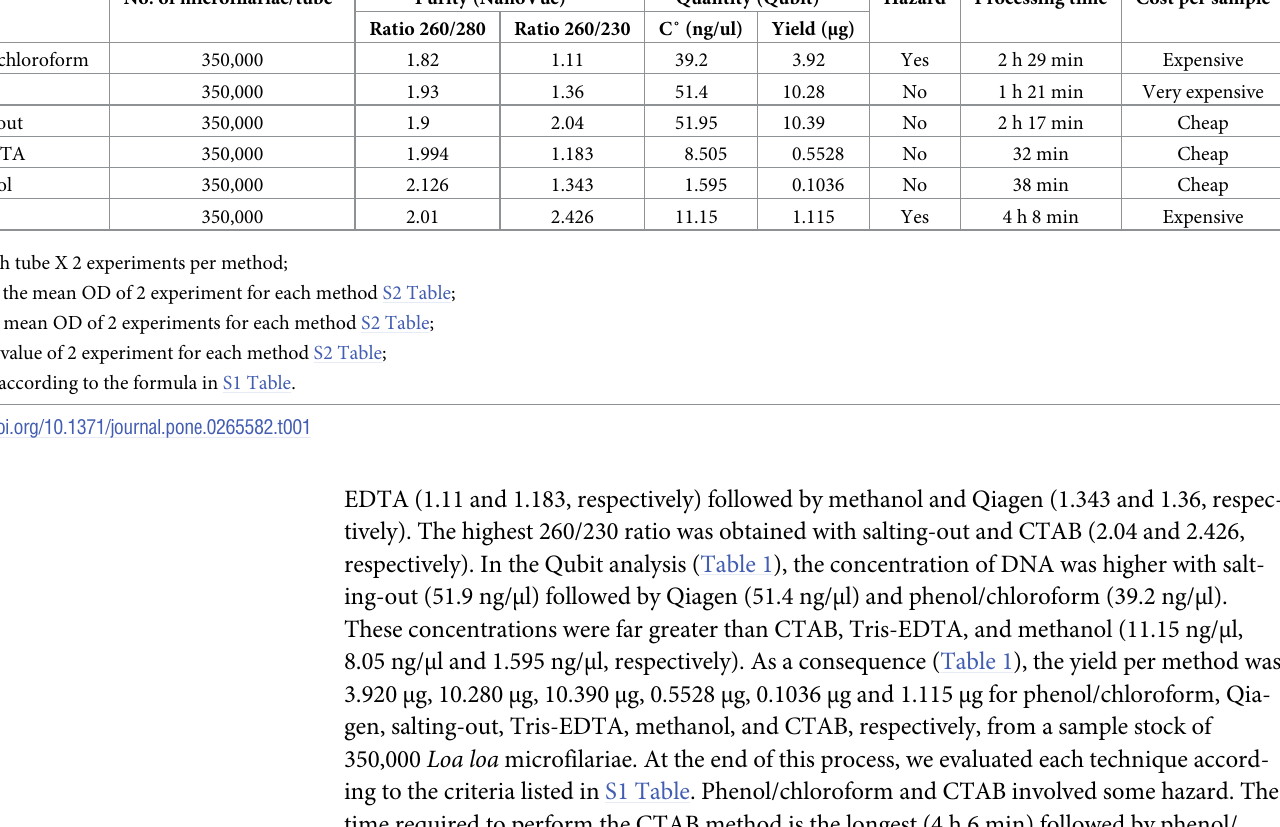
Table 1. Comparative analysis of spectrometric data from six DNA extraction methods.